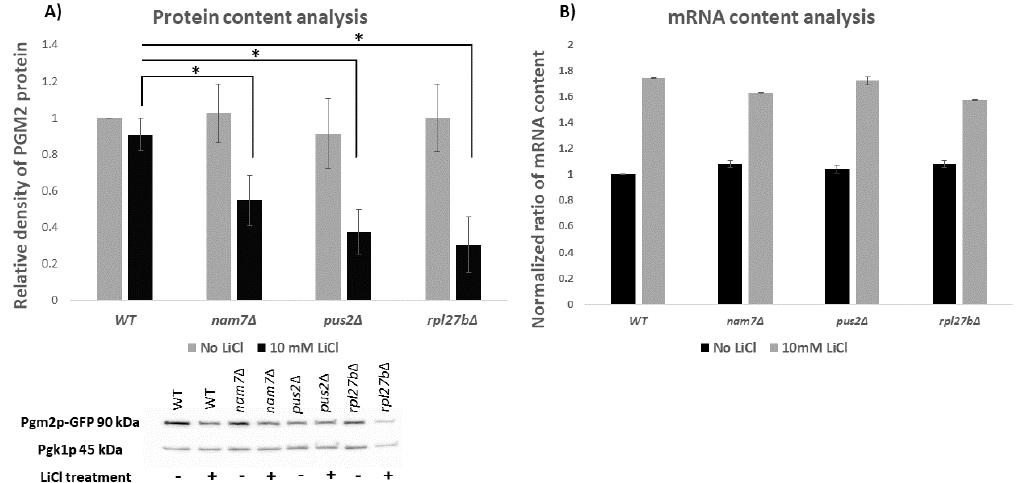
Figure 3. Protein and mRNA content analysis. ( A ) Protein content analysis of Pgm2p-GFP protein in deletion yeast strains for nam7 ∆ , pus2 ∆ , and rpl27b ∆ . Western blot analysis was used to measure the protein content for Pgm2p-GFP protein in the absence or presence of LiCl (10 mM). Pgk1p was used as housekeeping gene and the values are normalized to that. ( B ) mRNA content analysis of PGM2 in nam7 ∆ , pus2 ∆ , and rpl27b ∆ . qRT-PCR was used to evaluate the content of PGM2 mRNA in yeast gene deletion mutants related to WT strain and normalized to PGK1 mRNA levels. Each experiment was repeated at least three times. * ( p -value ≤ 0.05) represent statistically significant results compared to WT. Error bars represent standard deviation.